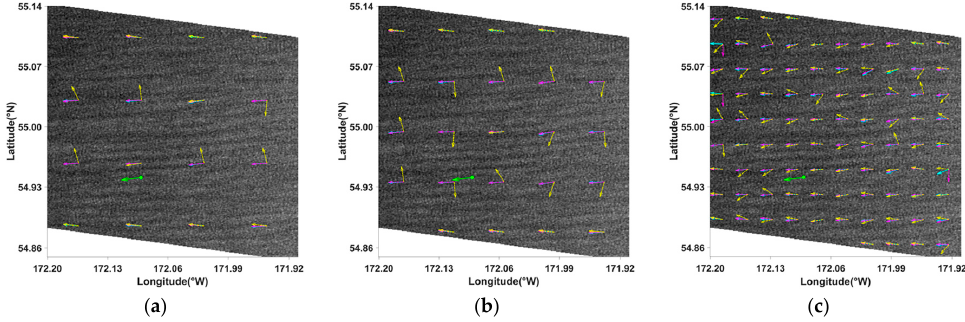
Figure 10. Wind directions retrieved by the three methods on different grids of the Radarsat-2 image acquired at 17:58, 11 February 2011 in VV polarization: ( a ) 8 km grid, ( b ) 6.4 km grid, ( c ) 3.2 km grid. Yellow, magenta and cyan arrows indicate wind directions retrieved by the FFT-like, LG-like and ILG methods, respectively. The buoy (46073) is marked as the green dot and the in situ measurement is indicated by the green arrow.